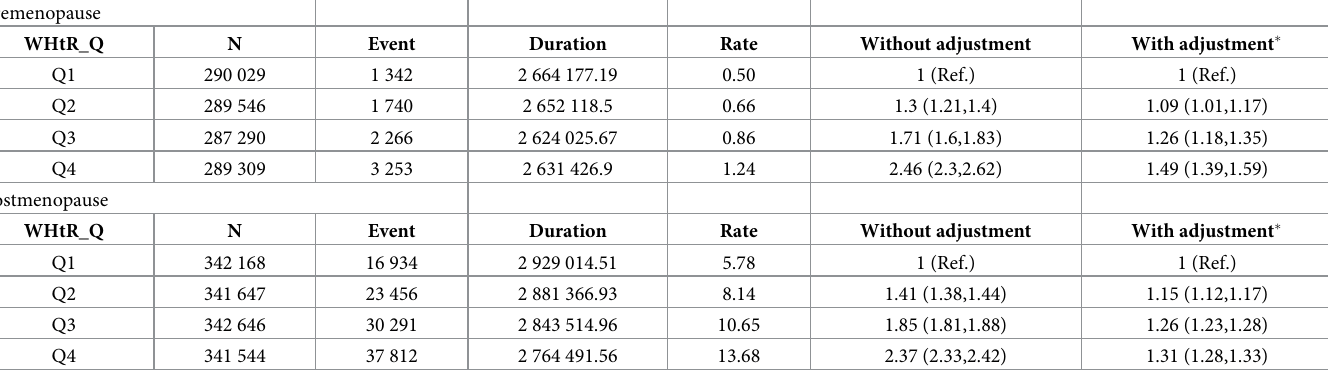
Table 7. Cox proportional hazards regression analysis for the development of vertebral fracture according to WHtR_Q in the premenopausal and the postmeno- pausal groups. Premenopause